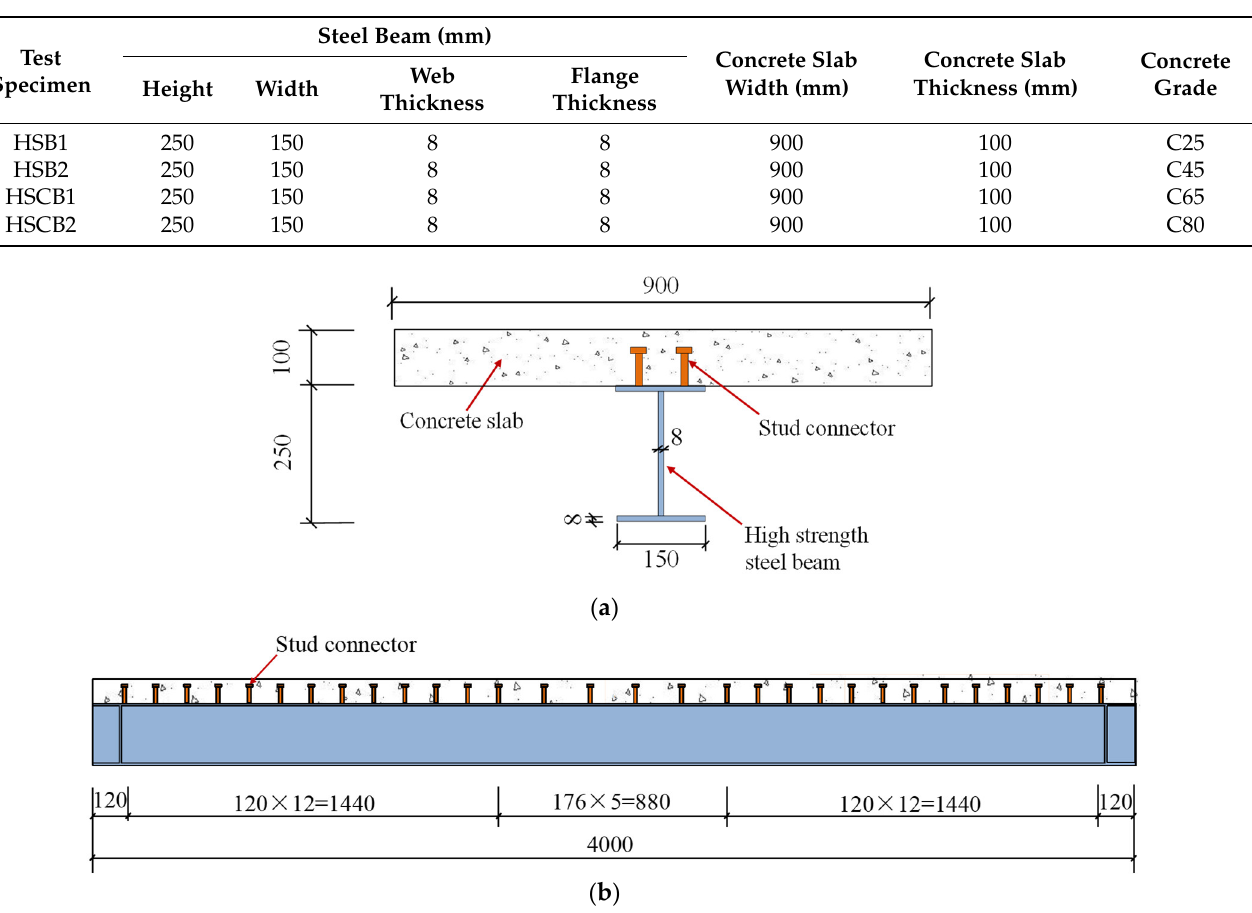
Table 1. Main parameters of composite beams.